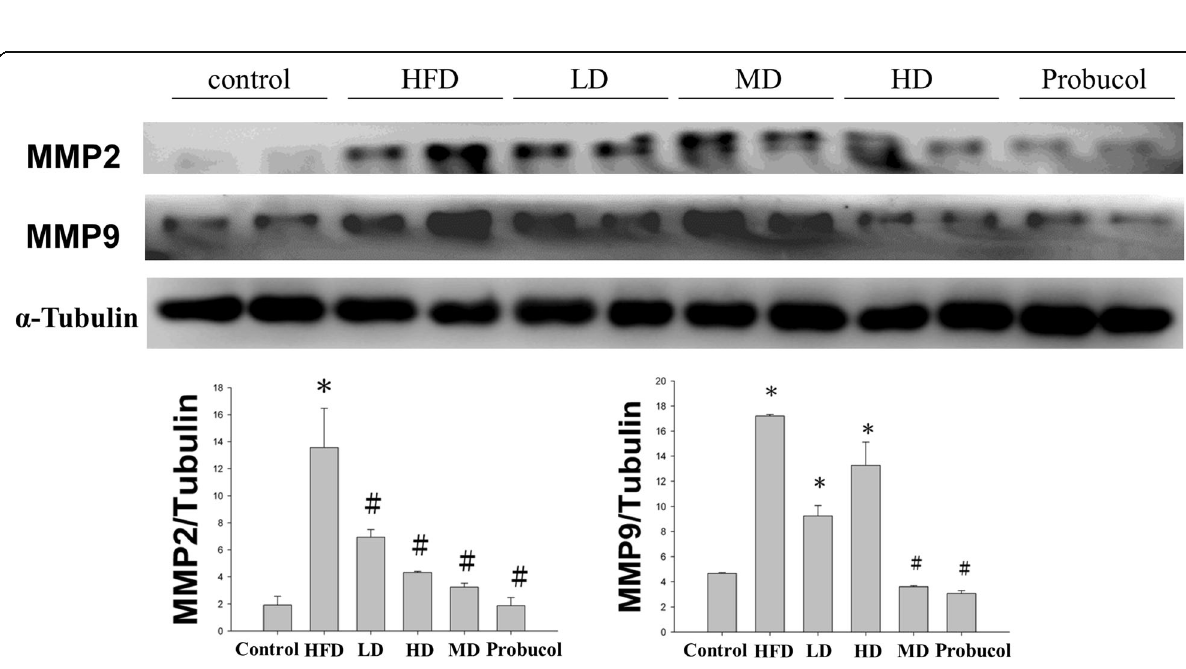
Fig. 4 Expression analysis of Fibrosis related proteins by western blotting. Levels of apoptosis and survival related proteins in the liver sections of Control, HFD fed hamsters (HFD), HFD fed hamsters treated with low dose of APPH (L-APPH), HFD fed hamsters treated with moderate dose of APPH (M-APPH), HFD fed hamsters treated with high dose of APPH (H-APPH) and HFD fed hamsters treated with probucol. . n = 5, * p < 0.05 when compared with the Control group; # p < 0.05 when compared with HFD